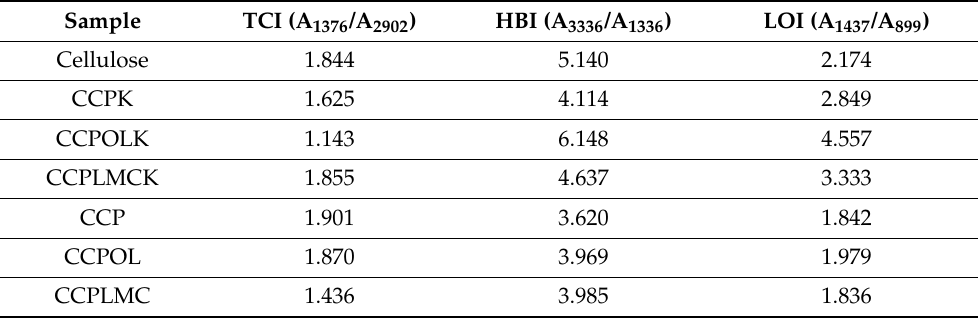
Table 1. Total crystalline index (TCI), lateral order index (LOI), and hydrogen bound intensity (HBI) values obtained from the FTIR spectra analysis of the